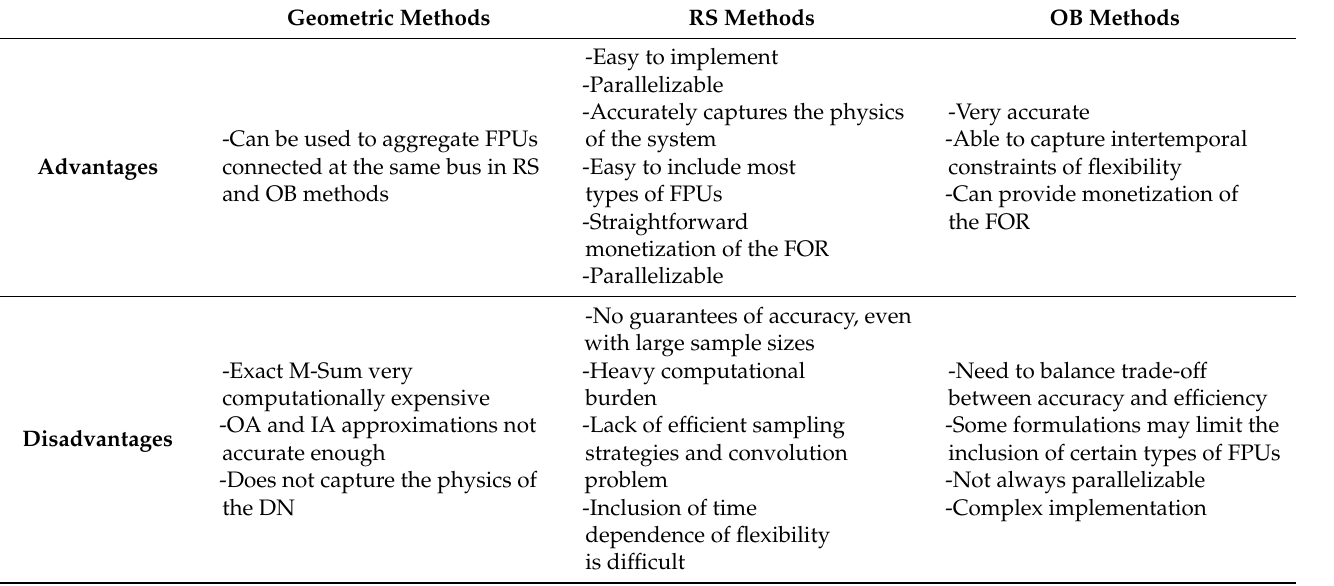
Table 5. Summary of the advantages and disadvantages of the three FOR estimation